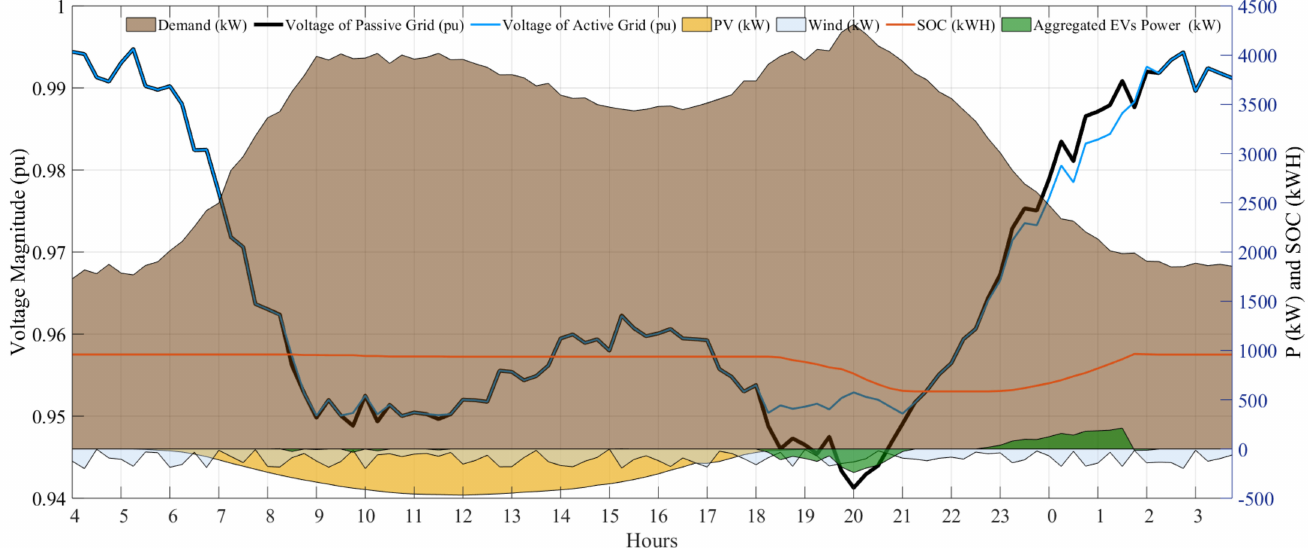
Figure 18. Measured profiles: Load profile at the secondary substation, PV and wind profiles and the aggregated power of